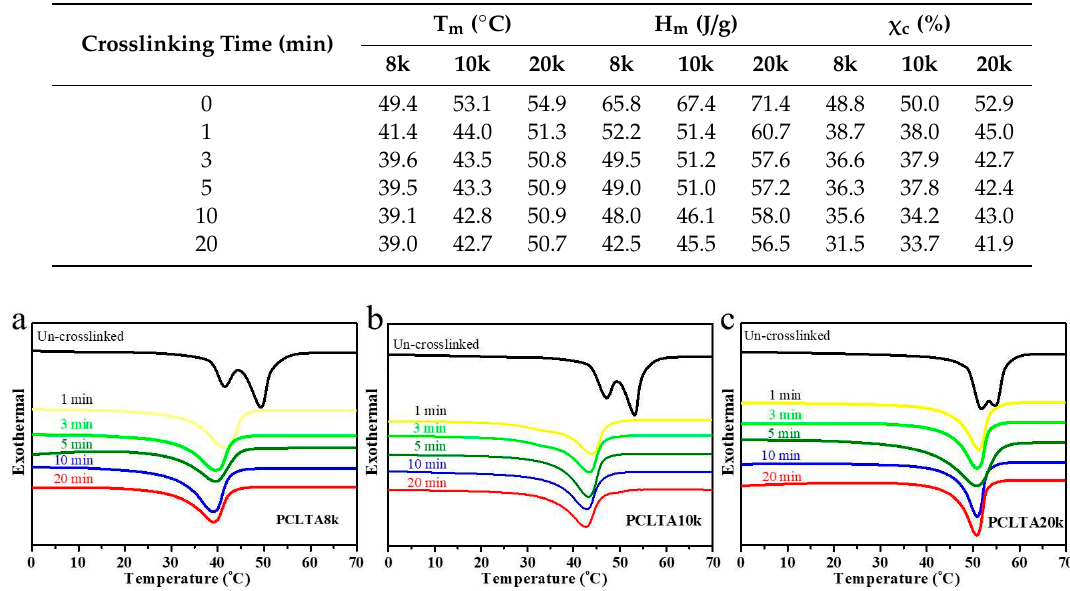
Table 1. Thermal properties of the crosslinked PCLTAs with di ff erent crosslinking time.